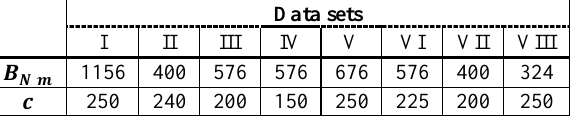
Table 2: Parameter selection for (cid:1828) and (cid:1855) . (cid:3015) _ (cid:3040) In connection with the kernel density estimation, impact maps with a radius of 20 m (Scenario 1) and 250 m (Scenario 2) are derived. For this purpose, the bandwidth ℎ from equation (4) is varied based on the image scale and an appropriate threshold (cid:1868) for the probabilities is set in a way that the area around the center of a detected bomb crater is always classified as contaminated within a radius of 20 m respectively 250 m for single detections.